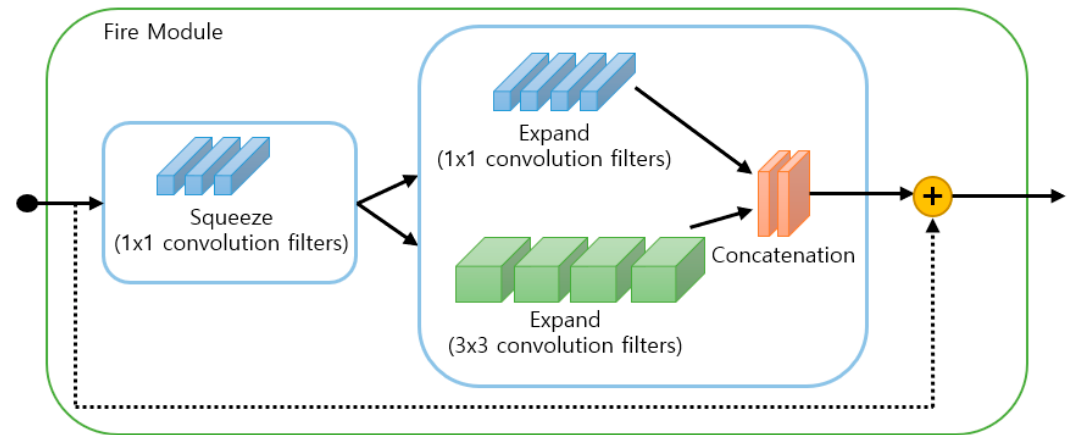
Figure 3. Structure of the fire module in SqueezeNet [21].